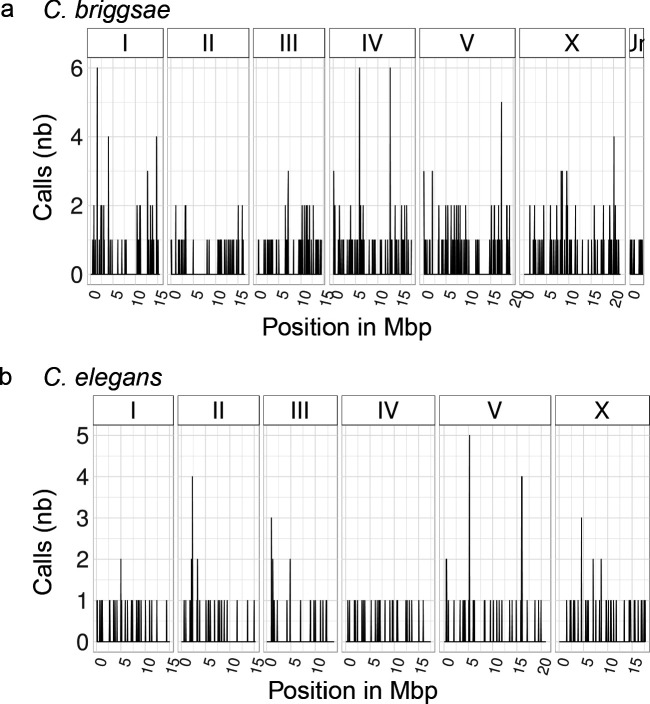
Genome-wide distribution of spontaneous mutations accumulated in the MA lines sequenced for this study.The number of predicted variant calls in all MA lines per non-overlapping 50 kbp window is plotted over the entire nuclear genome of C. briggsae (A) and C. elegans (B). The data corrspond to two MA lines in C. briggsae and four MA lines in C. elegans.